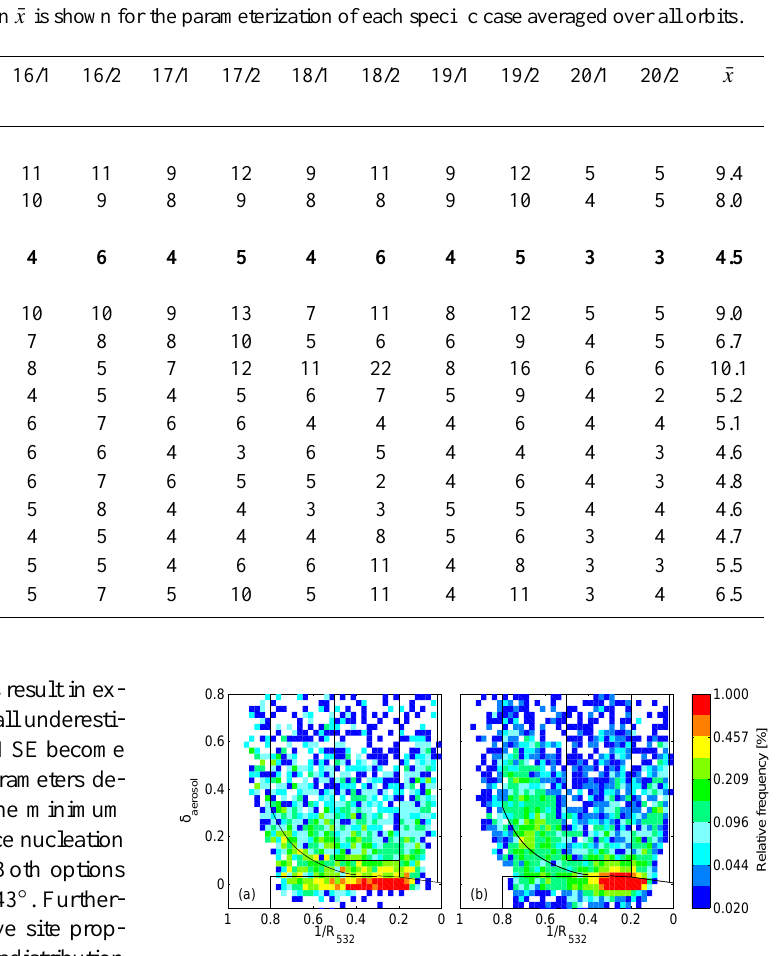
Fig. 7. Normalized composite 2-D histogram of CALIOP PSC ob- servations (a) and simulated PSCs (b) from selected orbits (standard case shown in Table 1) within the period of synoptic-scale ice dur- ing the 2009/2010 Arctic winter over the altitude range from 18 to